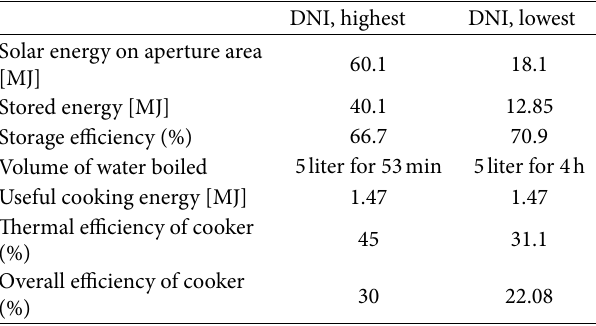
Table 6: Comparison of efficiencies for the conditions of higher and lower DNI.